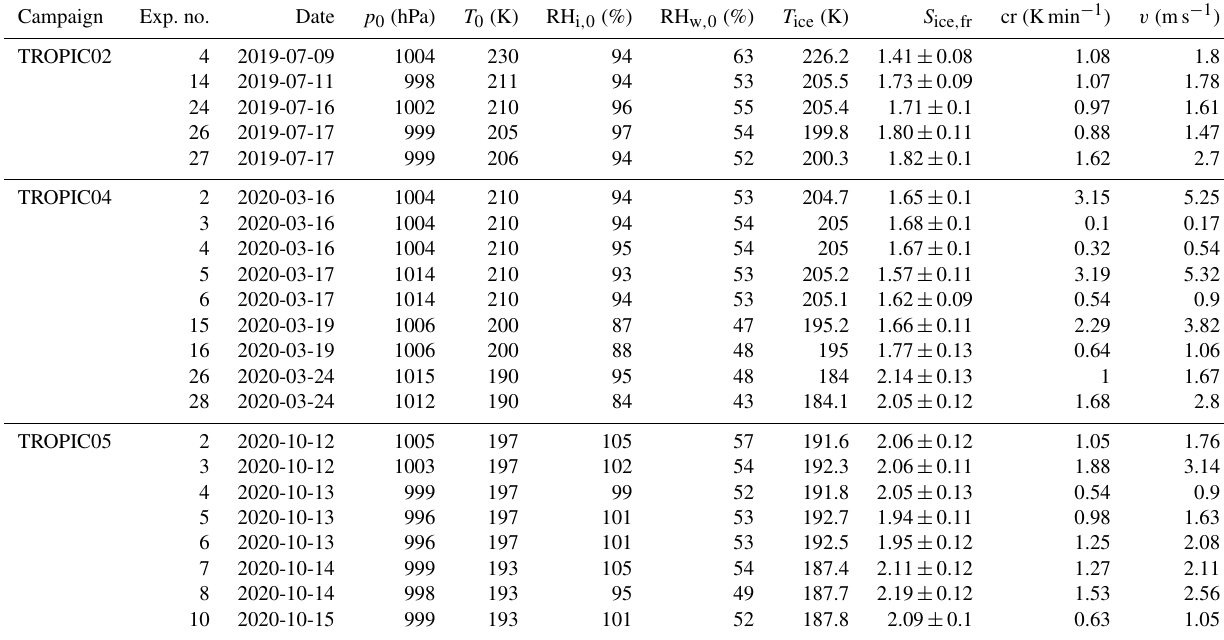
Table B3. Summary of H 2 SO 4 / H 2 O AIDA experiments part III. The considered experiments are listed together with the corresponding campaign, the experiment number, the date of the experiment, the starting pressure p 0 , the starting temperature T 0 , the starting relative humidity with respect to ice RH i , 0 and liquid water RH w , 0 , the freezing onset temperature T ice , the ice saturation ratio at freezing onset S ice , fr , the cooling rate cr, and the corresponding vertical velocity v at the freezing onset. Campaign Exp.